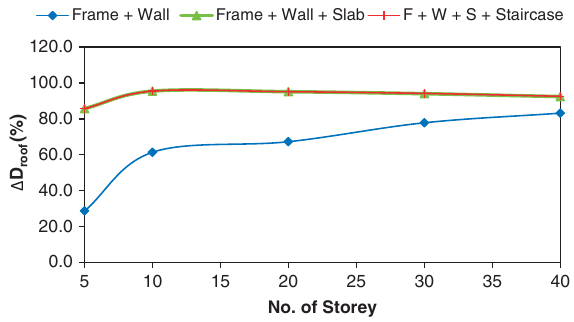
Fig. 12. Increment of roof displacement, Δ D roof , comparing effect of